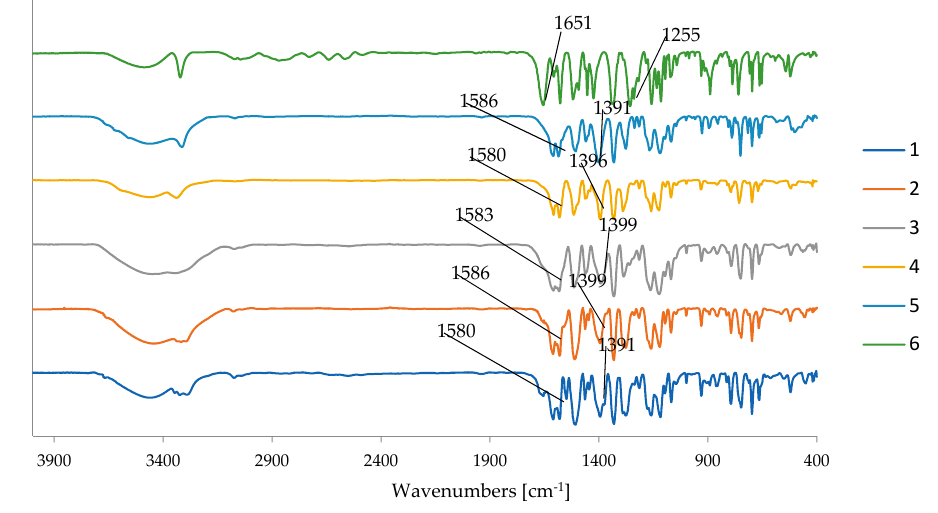
Figure 4. FTIR spectra of 1 – 5 complexes and free ligand 6 .